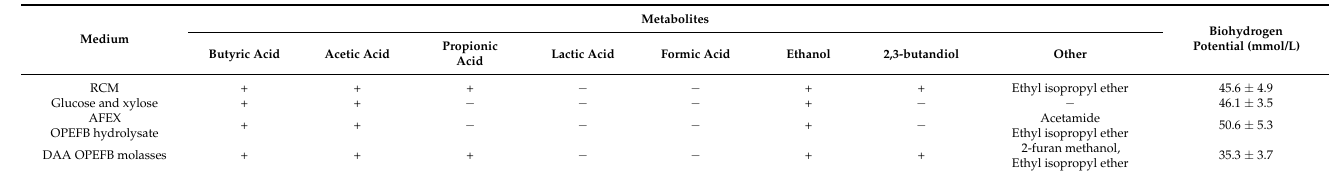
Table 2. Qualitative analysis of metabolites after biohydrogen fermentability test using various fermentation media.